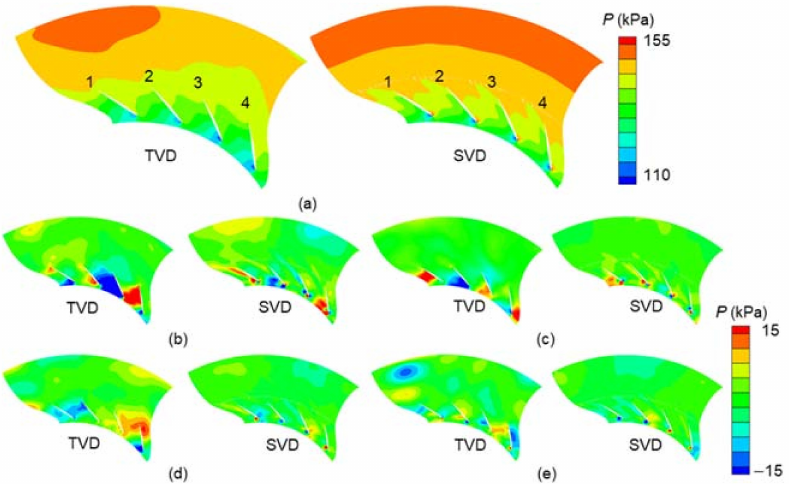
Figure 21. The spatial patterns for POD modes of pressure fields at 0.95 span: ( a ) zeroth-order POD mode (averaging flow field); ( b ) 1st-order POD mode; ( c ) 2nd-order POD mode; ( d ) 3rd-order POD mode; ( e ) 4th-order POD